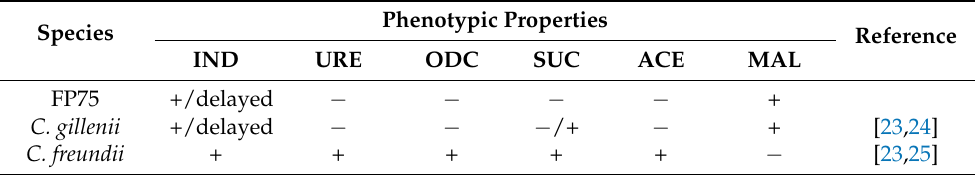
Table 1. Phenotypic differentiation between Citrobacter gillenii and Citrobacter freundii .